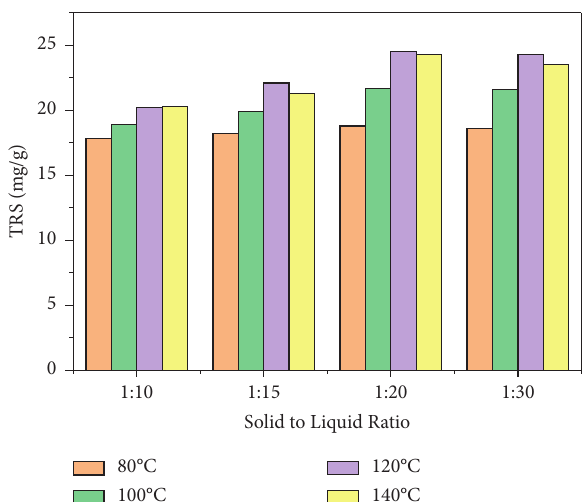
Figure 6: The effect of solid to liquid ratio and hydrolysis temperature on the yield of total reducing sugar (TRS) from Teff straw (dilute sulfuric acid concentration � 4 v/v (%) and hydrolysis time � 60min). Table 5: ANOVA for the quadratic model for dilute sulfuric acid hydrolysis of Teff straw.